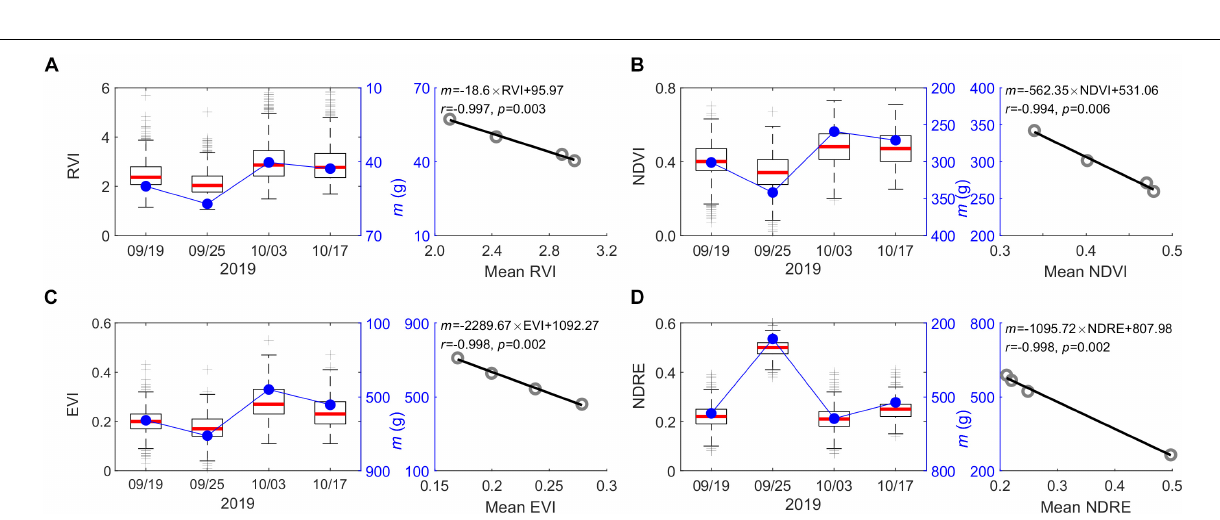
Frontiers in Plant Science |